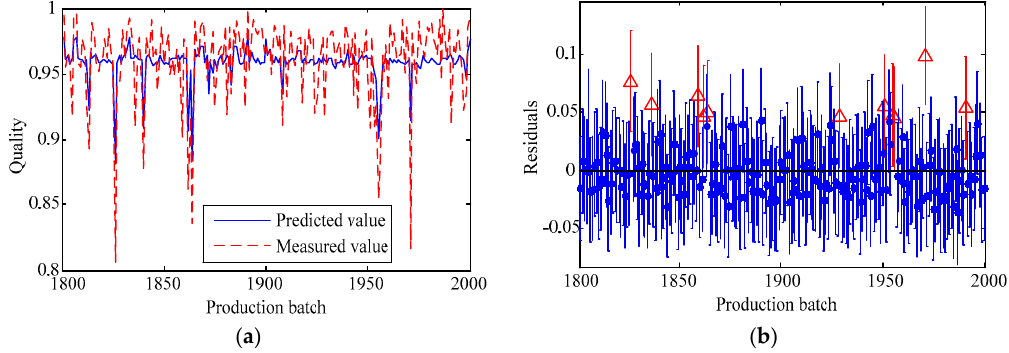
Figure 6. Prediction results of the MDRN model with 3-30-30-1 of Case 2: ( a ) plots the comparison with the measured and the predicted values, and ( b ) shows the residual error distribution.